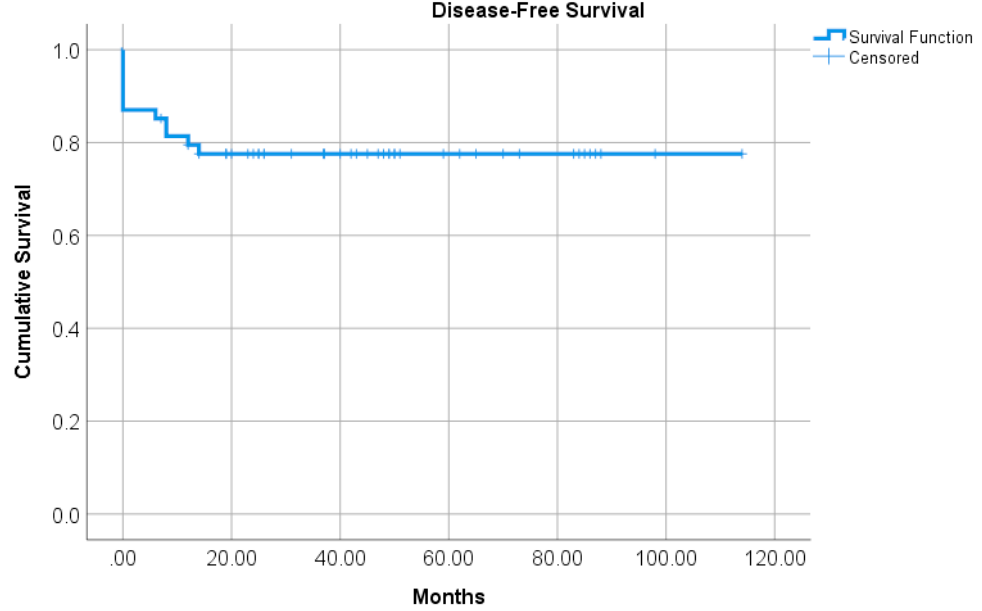
Figure 3. Kaplan-Meier curve for disease-free survival. At the end of the study, 77.8% of the patients were free from tumor.